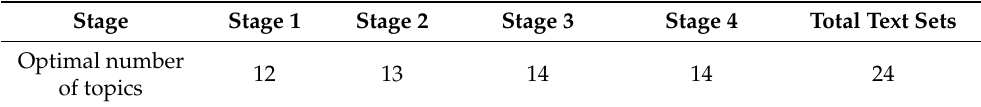
Table 2. Optimal number of topics in the text sets at each time